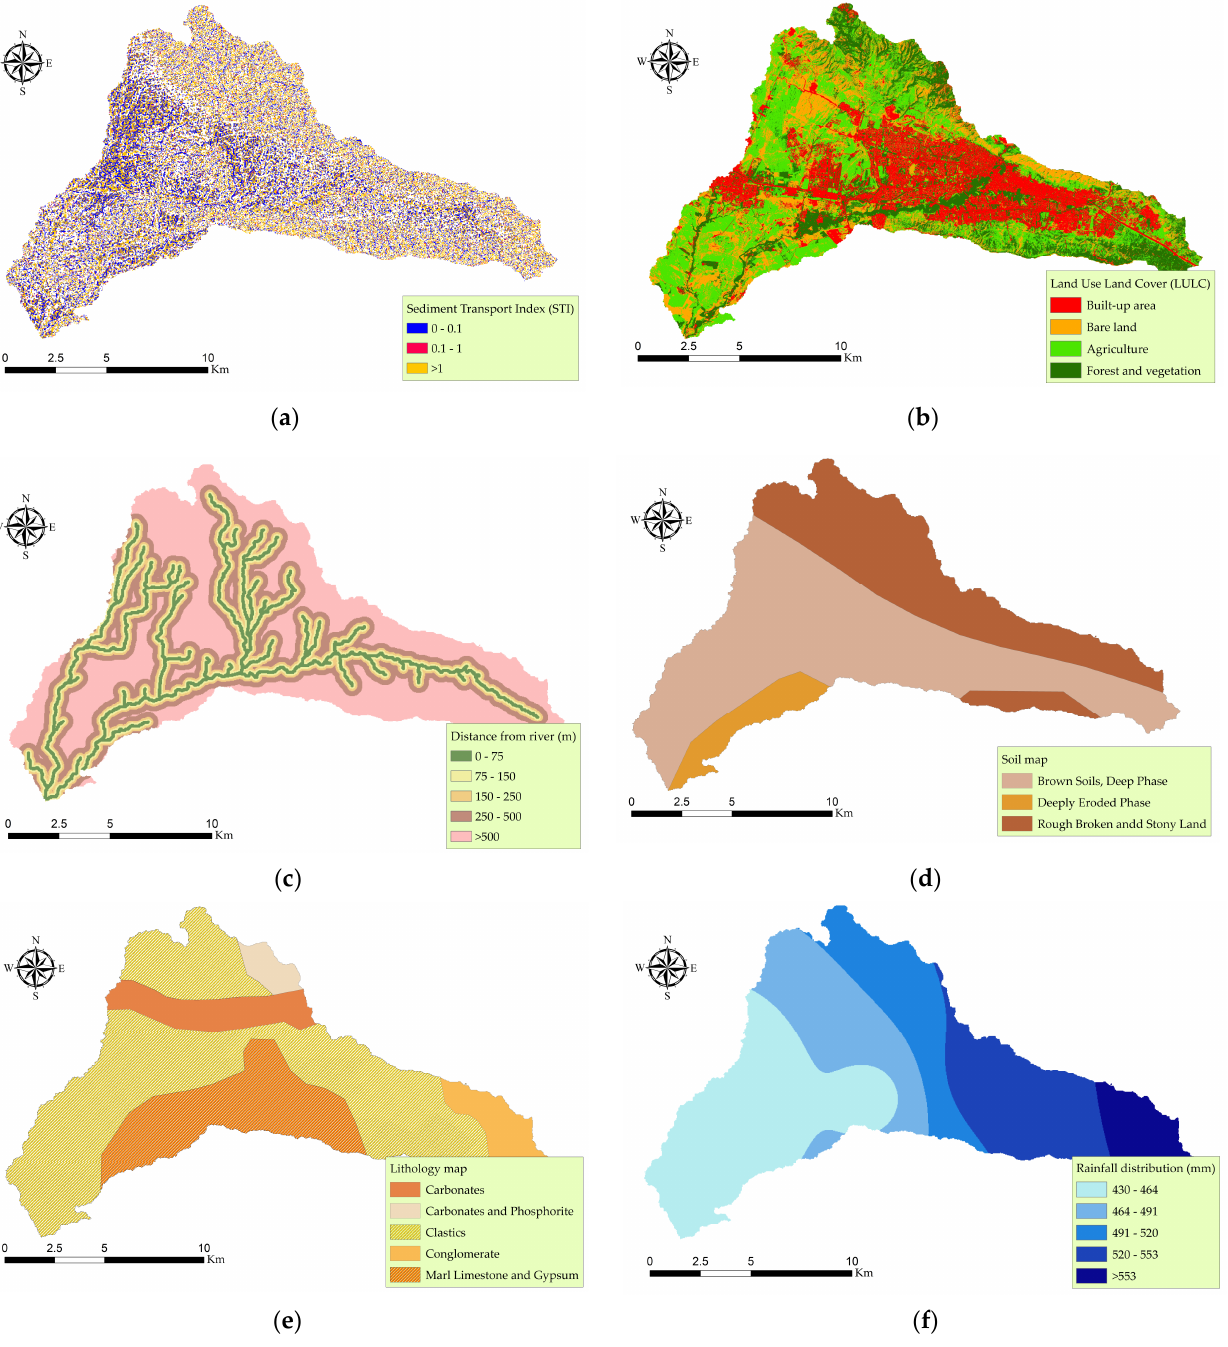
Figure 3. Thematic layers: ( a ) Sediment Transport Index, ( b ) Land use land cover, ( c ) Distance from river, ( d ) Soil, ( e ) Lithology [41] , ( f ) Rainfall.